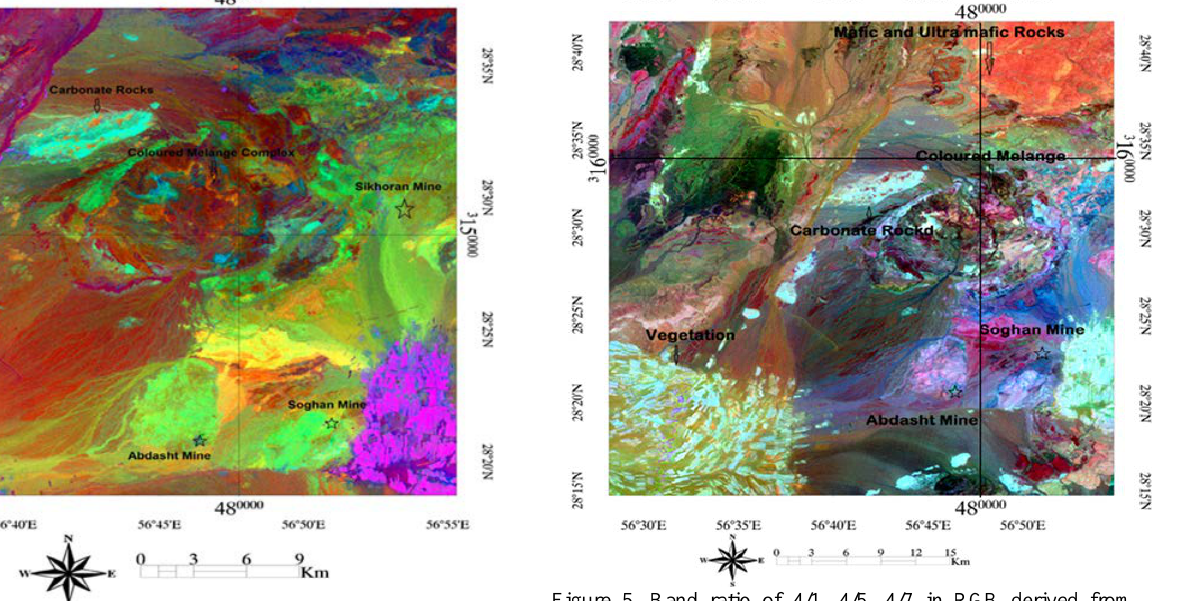
Figure 5. Band ratio of 4/1, 4/5, 4/7 in RGB derived from ASTER